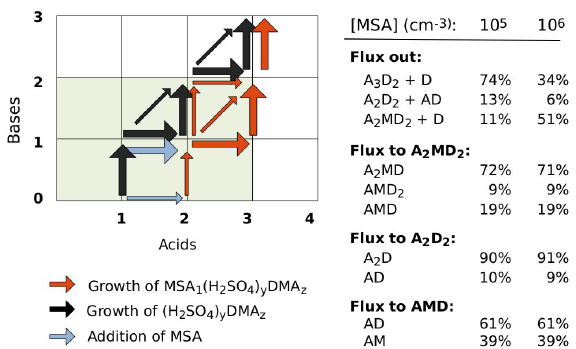
Figure 4. Main cluster formation pathways at T = 258K and [ H ] = 10 6 moleculescm − 3 , [ DMA ] = 10 8 moleculescm − 3 2 SO 4 and two representative MSA concentrations. Dominating growth pathways are represented by thick arrows. Fluxes to clusters formed via several different pathways are indicated in the side table, where A, M and D are shorthands for H 2 SO 4 , MSA and DMA,